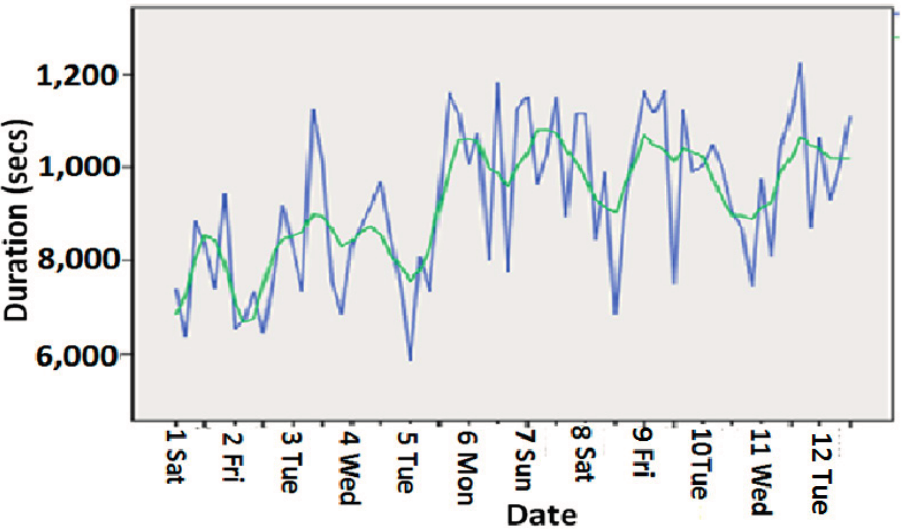
Figure 10. Toilet usage durations and trend.